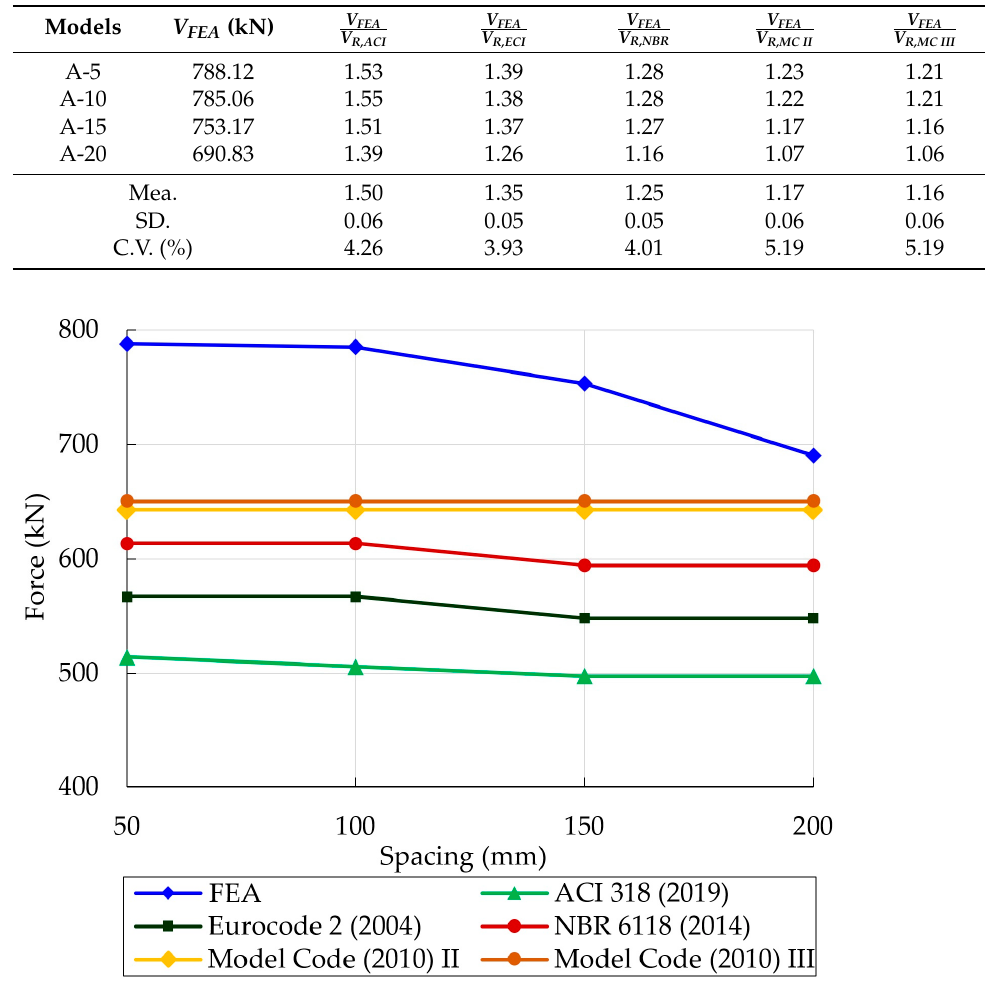
Figure 18. Failure load evolution in relation to the spacing of prestressing tendons (Series A) [11–